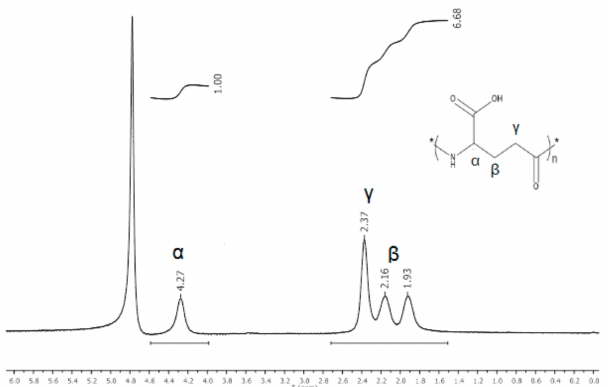
Figure 1. 1 H NMR spectrum of γ -PGA synthesized by Bacillus licheniformis ATTC9945a.